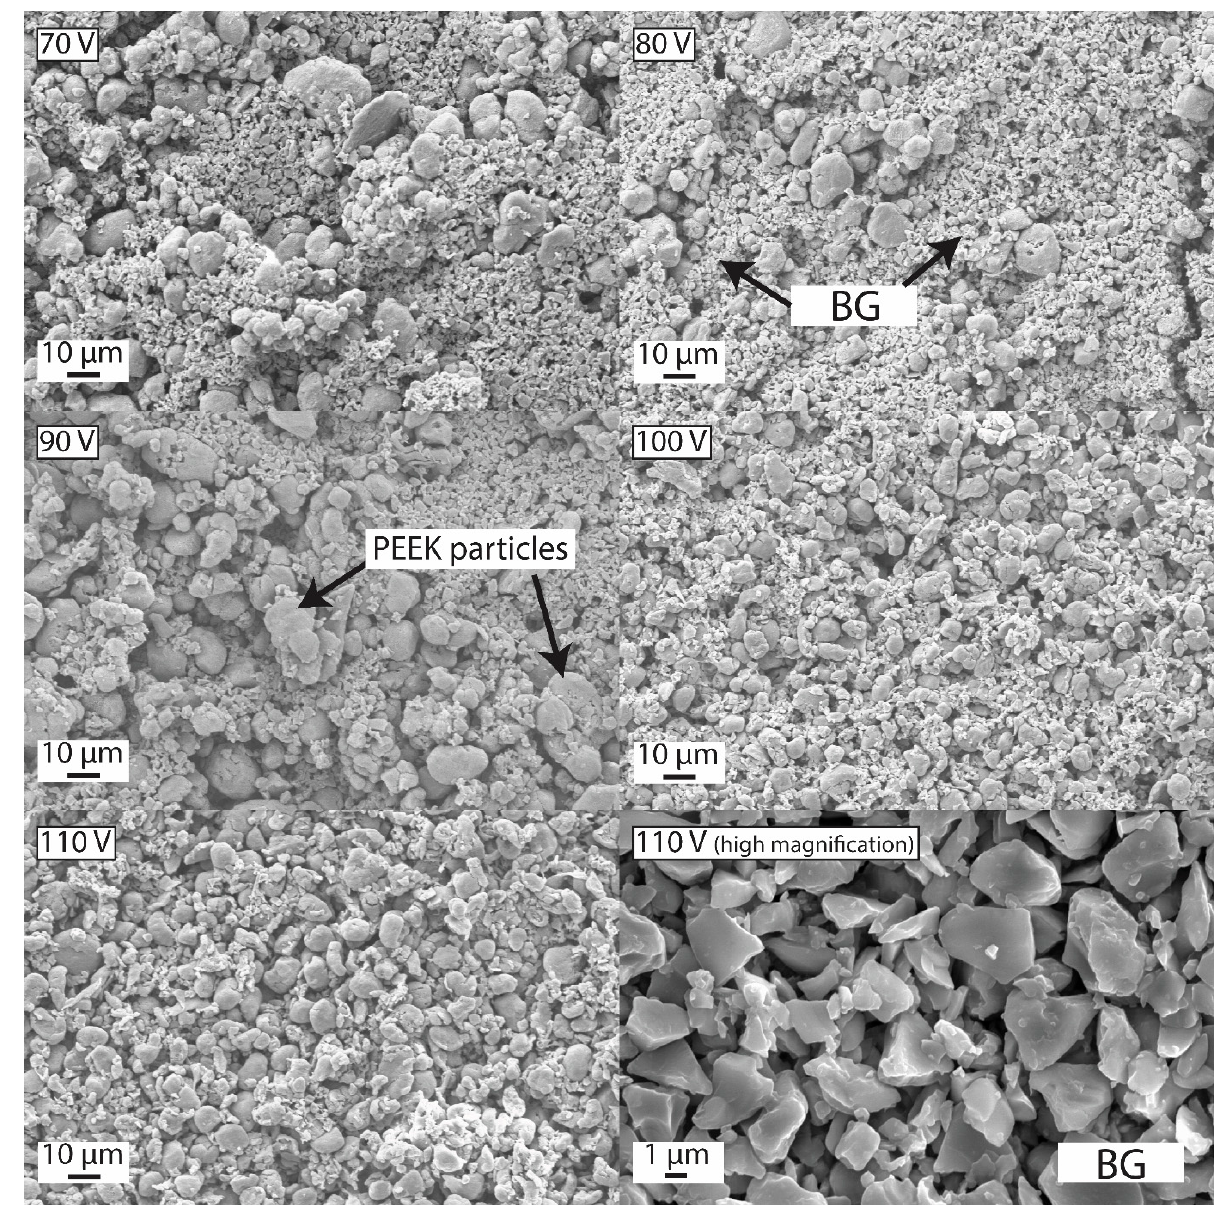
Figure 20. Effect of deposition voltage on the morphology of coatings at 120 s of deposition time and 5 mm of inter-electrode spacing. Reproduced from [94].